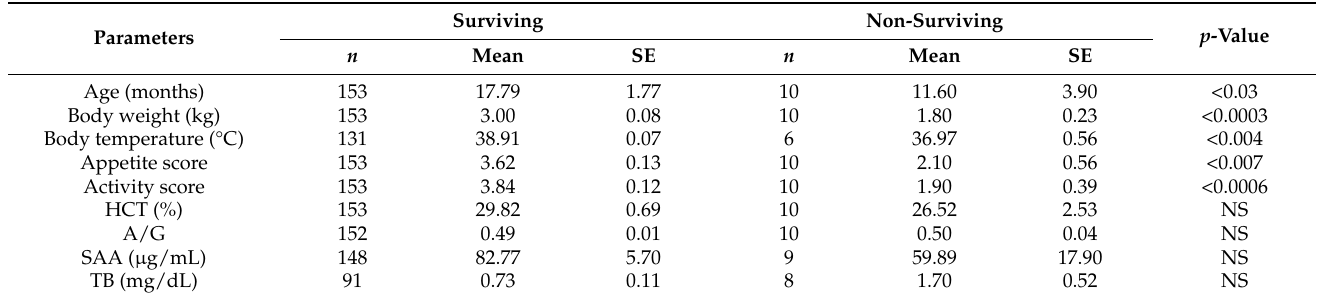
Table 5. Statistical comparison of signalment and clinical parameters between surviving and non- surviving cats with dry